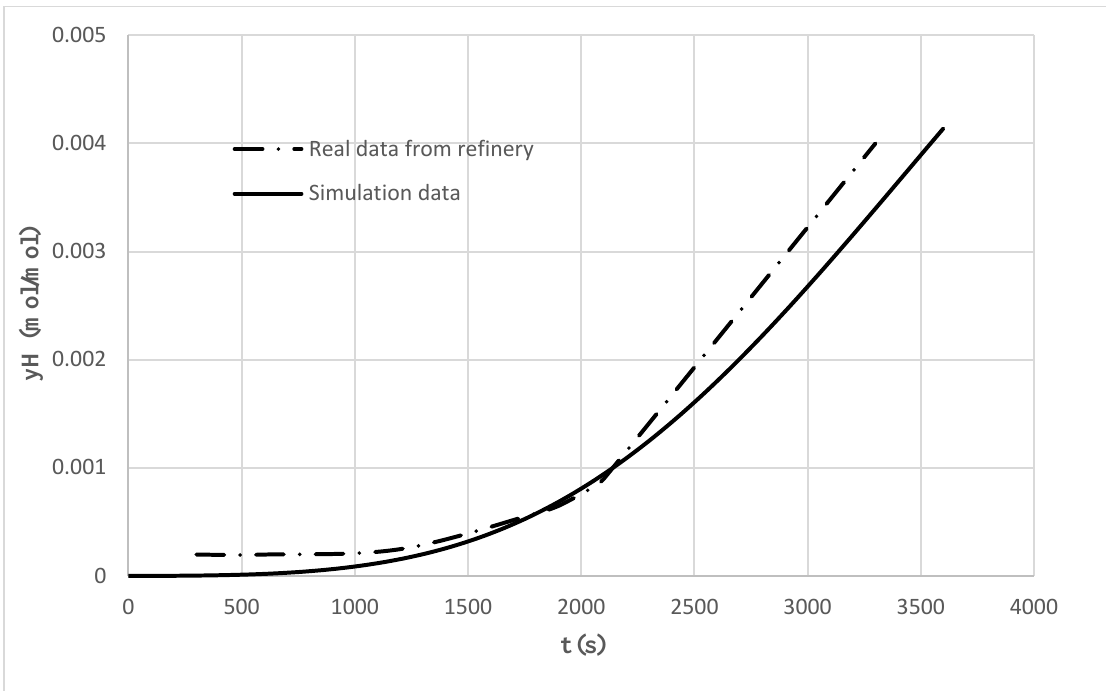
Figure 5. Comparison of simulation and industrial data of the refinery for the hexane mole fraction in the output stream.